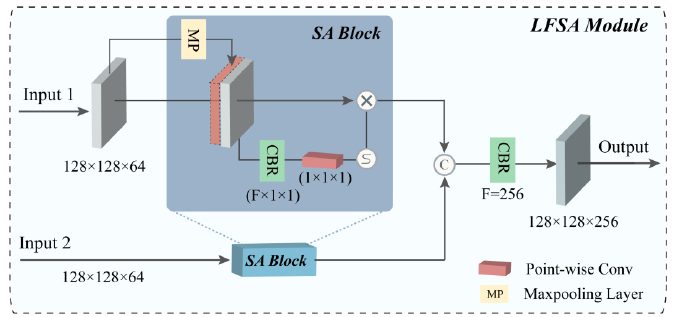
Figure 4. Illustration of the low-level feature spatial attention (LFSA) module. SA = spatial